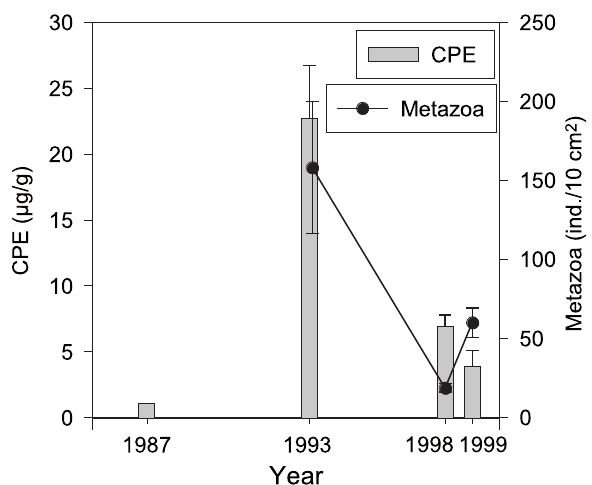
Fig . 5. – time series measurements of chloroplastic pigment equivalent (Cpe) and metazoan meiofauna abundances from differ- ent cruises in the ierapetra Basin [1987: meteor No 5/1 (tselepides and lampadariou, unpublished data); 1993: meteor No 25/1 (tse- lepides and lampadariou, 2004); 1998: meteor No 40/3 (present study); 1999: aegaeo trans-mediterranean cruise (danovaro et al .,